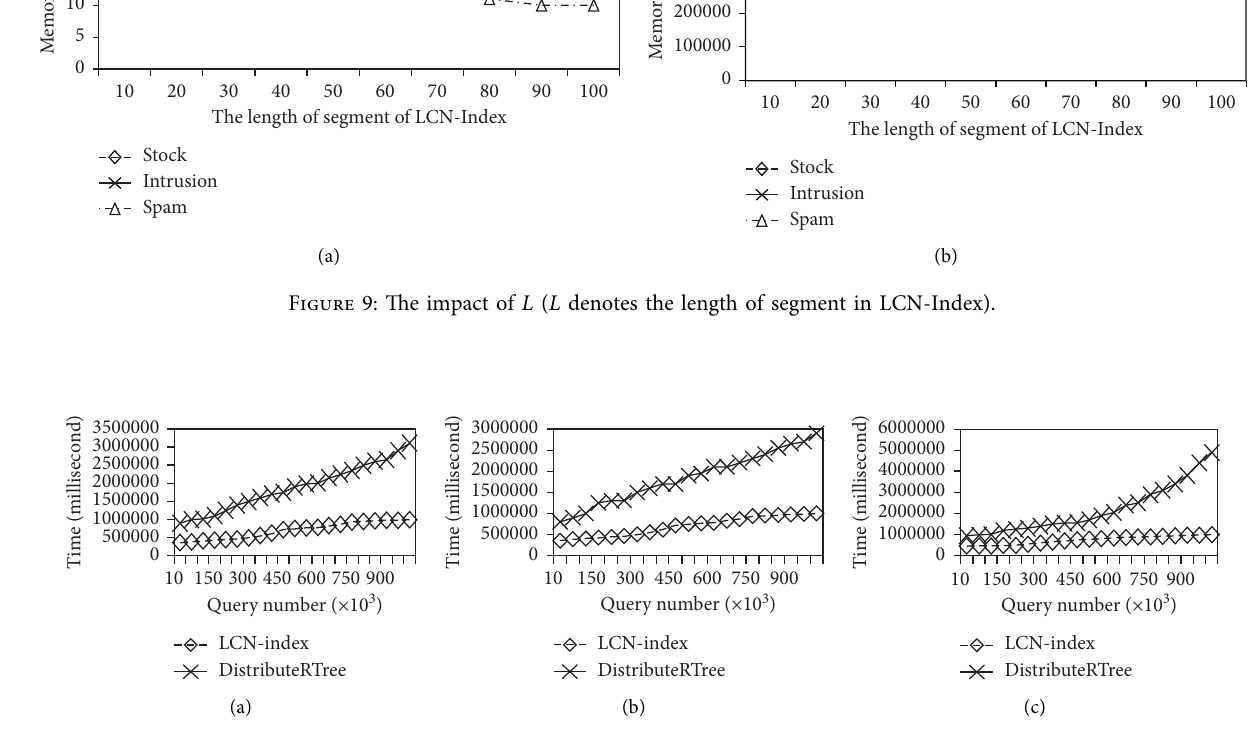
Figure 10: Comparisons between LCN-Index and the DistributeRTree with respect to different query set scale. It is obvious that LCN-Index outperforms DistributeRTree when the scale of query set